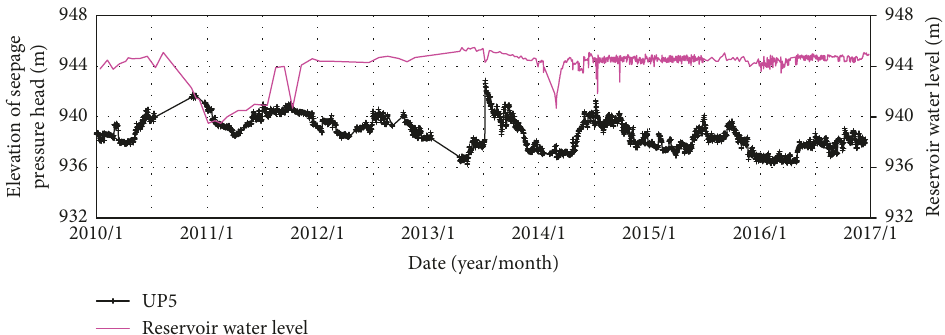
Figure 9: Time series for seepage pressure head at UP5 and reservoir water